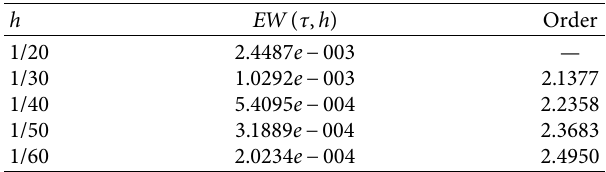
Table 4: Numerical convergence of scheme (50)–(59) with λ �